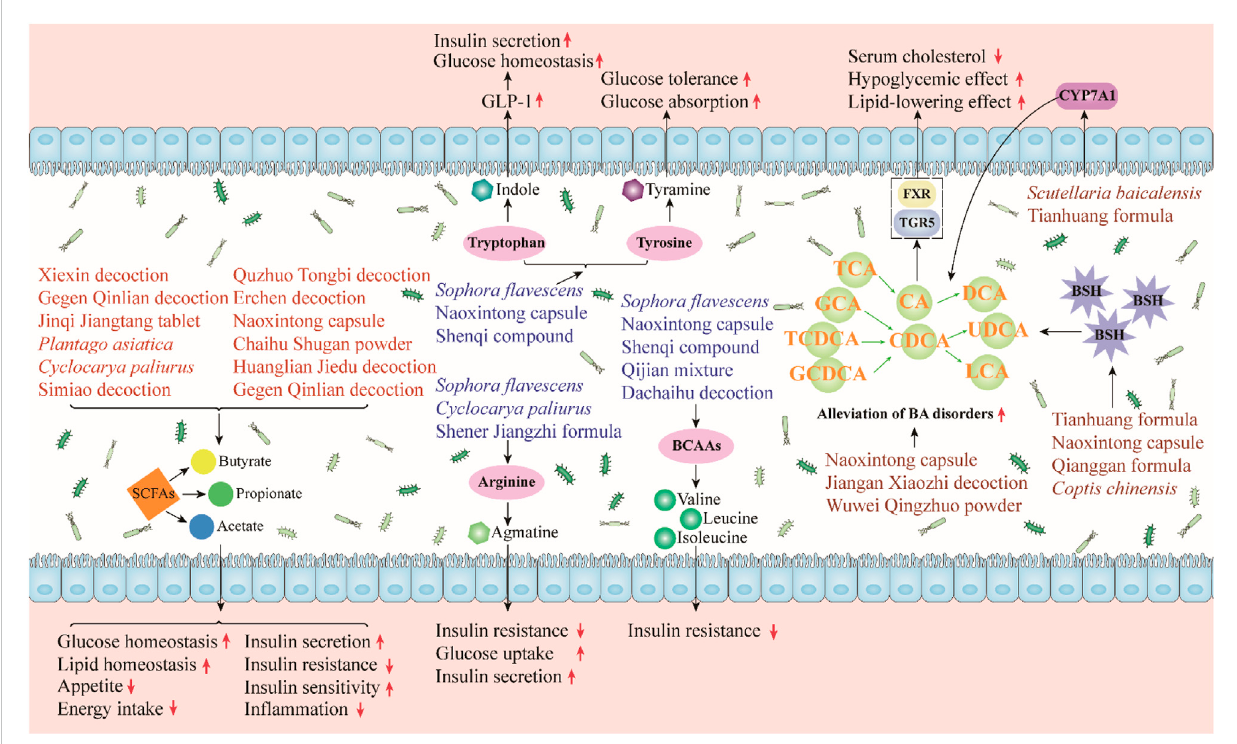
FIGURE 3 Herbal medicines regulate gut microbiota-derived metabolites, and they can regulate gut microbiota metabolites to alleviate metabolic diseases. SCFAs can improve glucose and lipid homeostasis, promote insulin secretion and sensitivity, and reduce appetite, energy intake, and insulin resistance. Indole can promote glucose homeostasis and insulin secretion. Tyramine, which is transformed from tyrosine, increases glucose tolerance and absorption. Agmatine can enhance glucose uptake and insulin secretion. Agmatine and BCAAs can reduce insulin resistance. Herbal medicines can relieve BA disorders by regulating BSH and CYP7A1 thereby improving the symptoms of metabolic